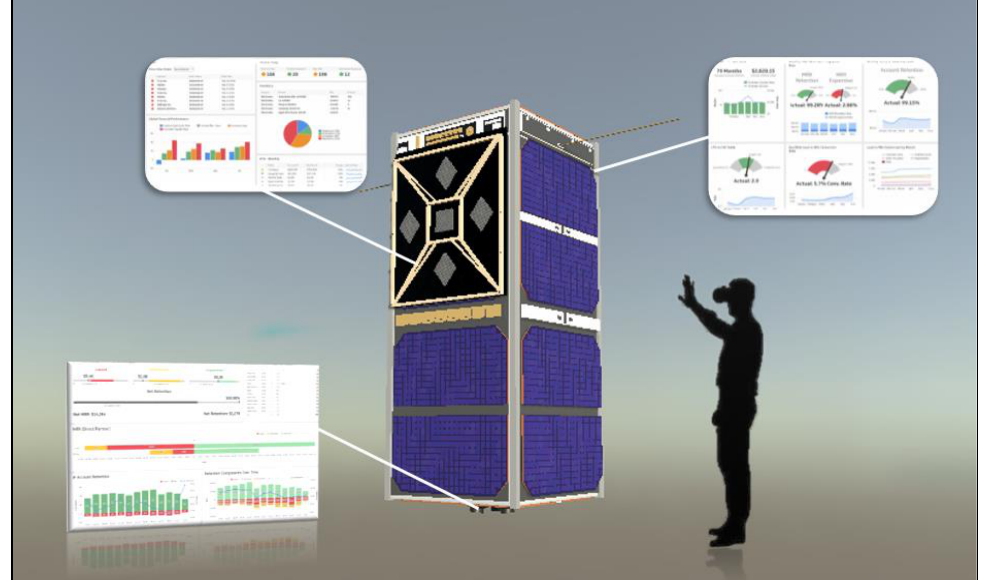
Figure 6. Immersive digital twin concept for service life monitoring and predictive maintenance of an in-orbit satellite. Part of the project Tesseract satellite presented at the 2022 EU Space Tech Expo.